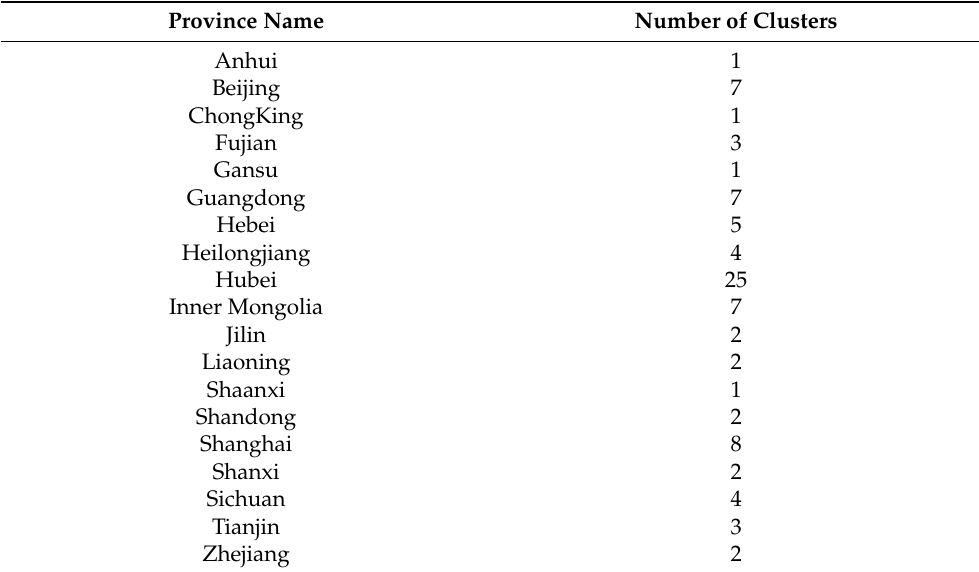
Table 3. Number of clusters in each province at the family-level with a maximum spatial scanning window size of 10